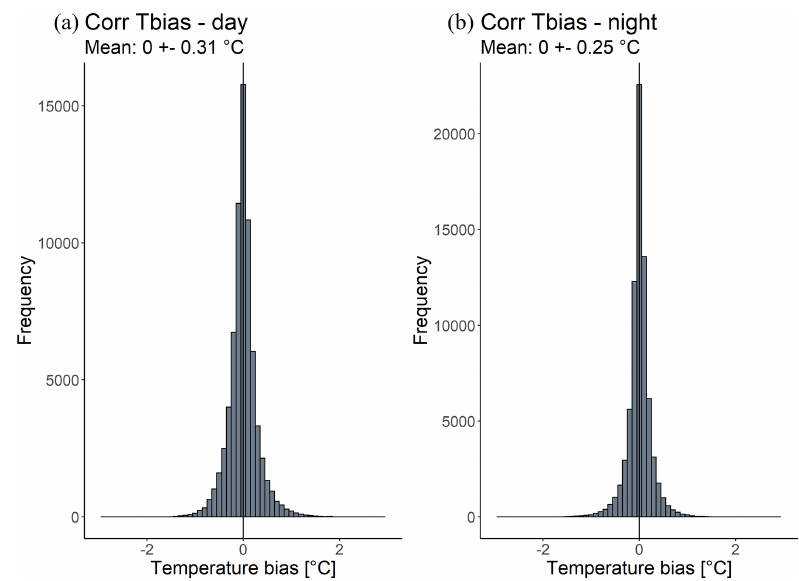
Figure 6. The corrected T bias after validation with the RF model for daytime (a) and night-time (b) . Mean biases and their standard deviations are given above the graphs. Note that the ranges on the y axis differ for the different subplots.